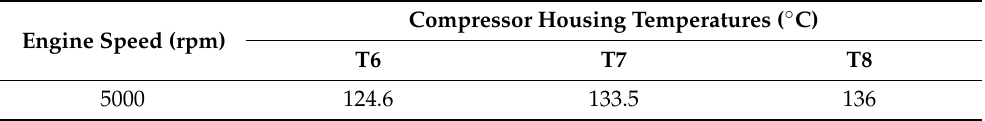
Figure 16. Turbine housing temperature distribution in cool-down mode. 4.5. Warm-Up Test To perform the turbine housing warm-up test, the thermal camera was located in the best position to capture photos in the test room. Then, the engine was turned on and the working point moved directly to the engine speed of 2000 rpm and 28 N.m. The exact time of capturing images was recorded. The turbine temperature versus time variation for the warm-up test is shown in Figure 17. Figure 18 shows the thermal images of the turbine housing and temperature at two locations, four times.